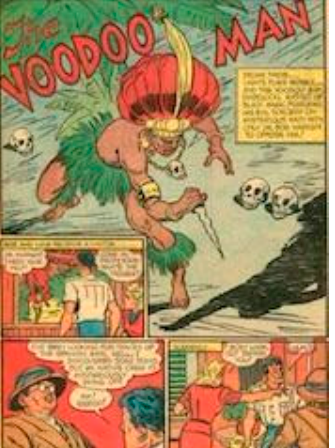
Figure 6. Early Black comic book villain, The Voodoo Man , 1940. Religions 2019 , 10 , x FOR PEER REVIEW